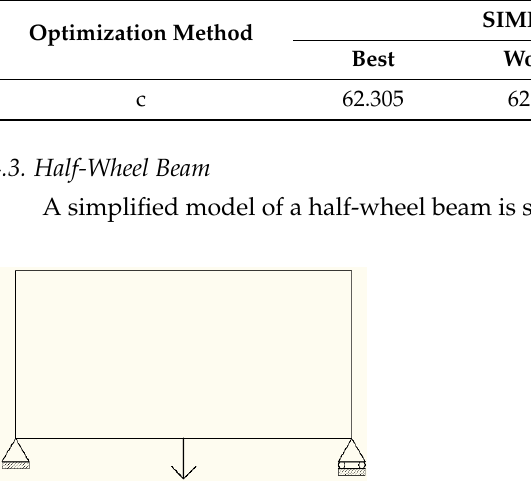
( j ) c = 2 6.3509 Figure 10. Final results from 10 runs of half-wheel beam. 5. Results and Comparison In this paper, the conventional genetic algorithm and SIMP method were combined. The conventional genetic algorithm and SIMP method program design are very mature,